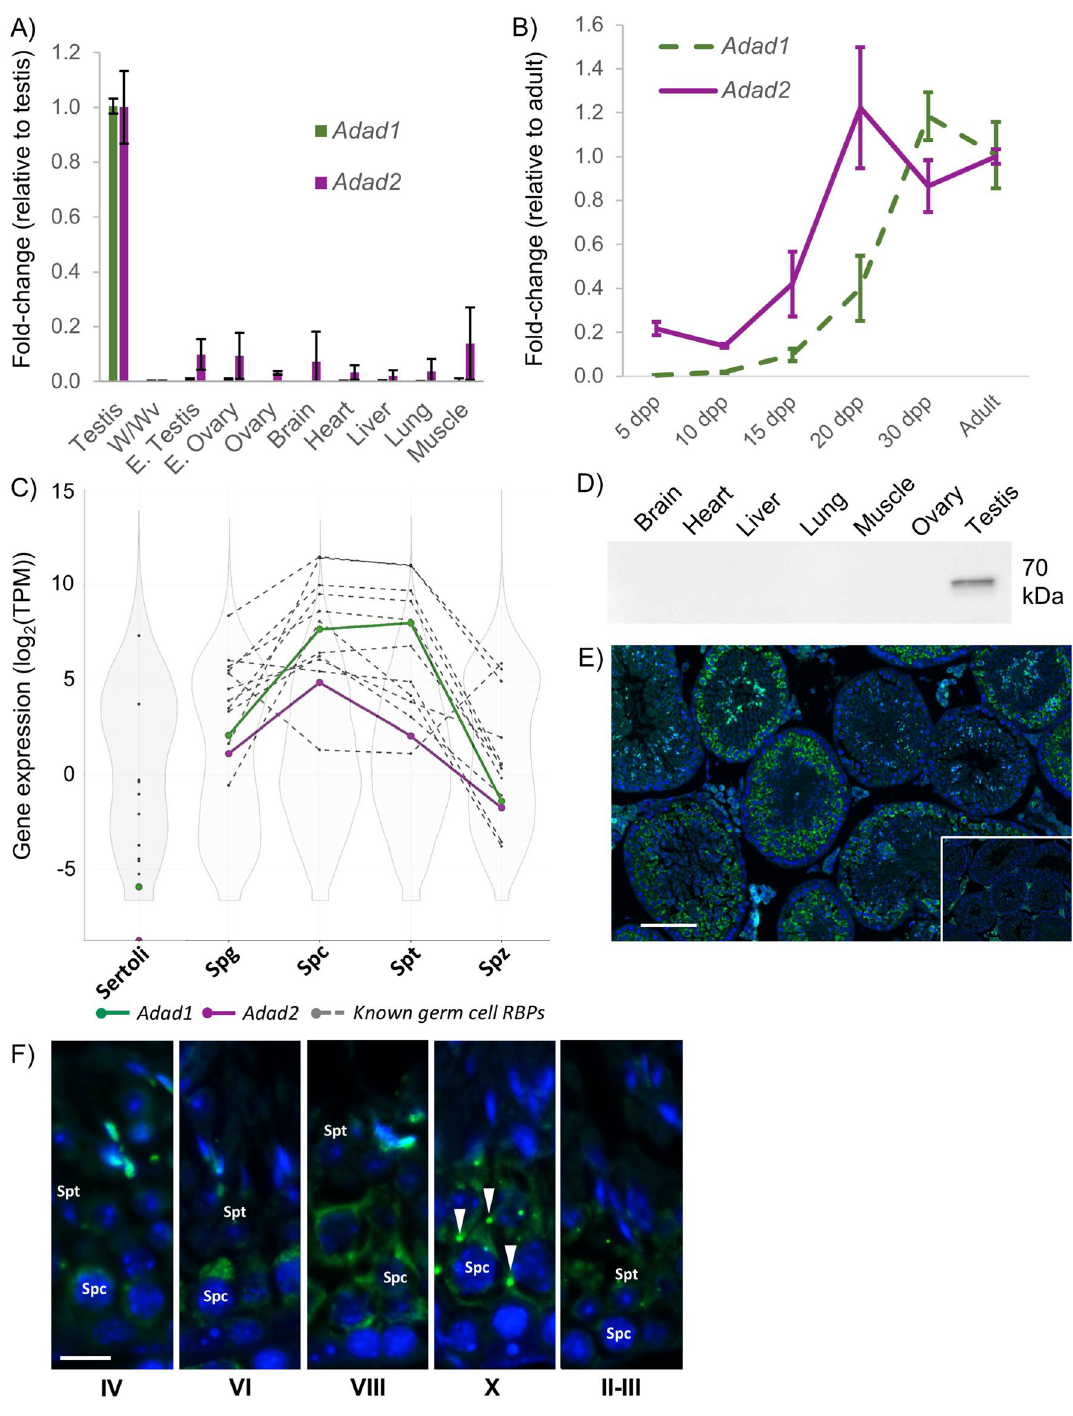
Figure 1. ADAD1 and ADAD2 are testis-specific adenosine deaminase domain containing proteins. ( A ) Adad1 and Adad2 expression as assessed by qRT-PCR across a panel of adult and embryonic wildtype and selected mutant tissues. W/Wv—adult testis from W/Wv males. E—embryonic, 15.5 days post-coitum. ( B ) qRT-PCR of Adad1 and Adad2 expression throughout testis development. dpp—days post-partum. N ≥ 3 per sample, error bars—standard deviation. ( C ) Expression of Adads derived from RNA-sequencing of isolated testicular somatic (Sertoli) and germ cells (23) relative to all expressed genes (violin plots—grey and white) and select genes encoding known male germ cell RNA binding proteins (line and dot plots—grey). Spg—spermatogonia, Spc—spermatocytes, Spt—round spermatids, Spz—spermatozoa. ( D ) Western blotting of ADAD2 across a panel of adult wildtype tissue. Similar results obtained for both ADAD2 antibodies, representative blot shown, confirmation of equal protein loading reported in Supp. Figure 3. ( E ) Localization of ADAD2 by immunofluorescence in adult mouse testis. Similar results obtained for both ADAD2 antibodies, representative images shown. Inset: no-primary antibody control. Bar—100 um. ( F ) ADAD2 spermatocyte localization by seminiferous tubule cross section stage. Arrow heads—perinuclear granules, bar—10 um. Spc— spermatocytes, Spt—round